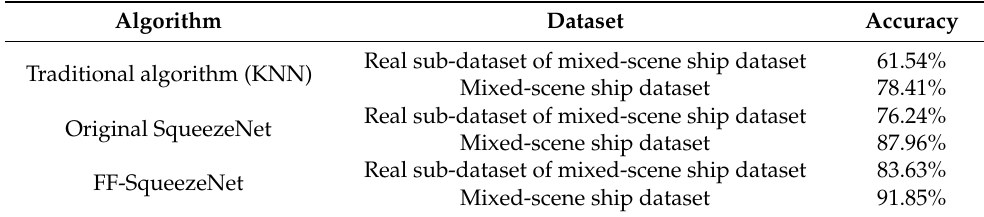
Table 4. Comparison of experimental results before and after adding simulation-scene